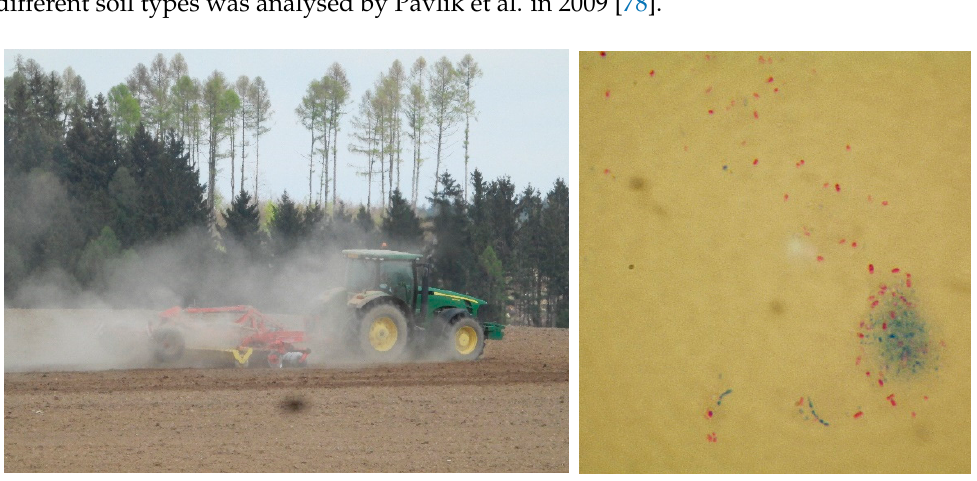
Figure 2. Soil ( left ) is often contaminated by mycobacteria; after Ziehl–Neelsen staining of the soil sample (magnified 1000 times) numerous acid-resistant, red-coloured polymorphic acid-fast rod- shaped mycobacterial cells were observed in this microscopic field of view ( right ). This sample was culture-positive for M. terrae and M. avium ssp. hominissuis